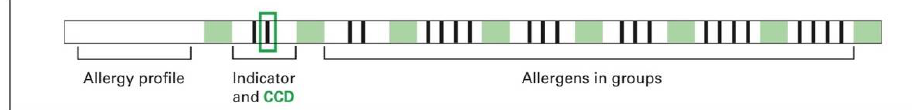
Figure 2. T he principal structure of the membrane strip with allergen Euroimmun